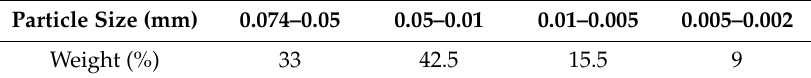
Table 2. Particle Size Distribution of the Tested